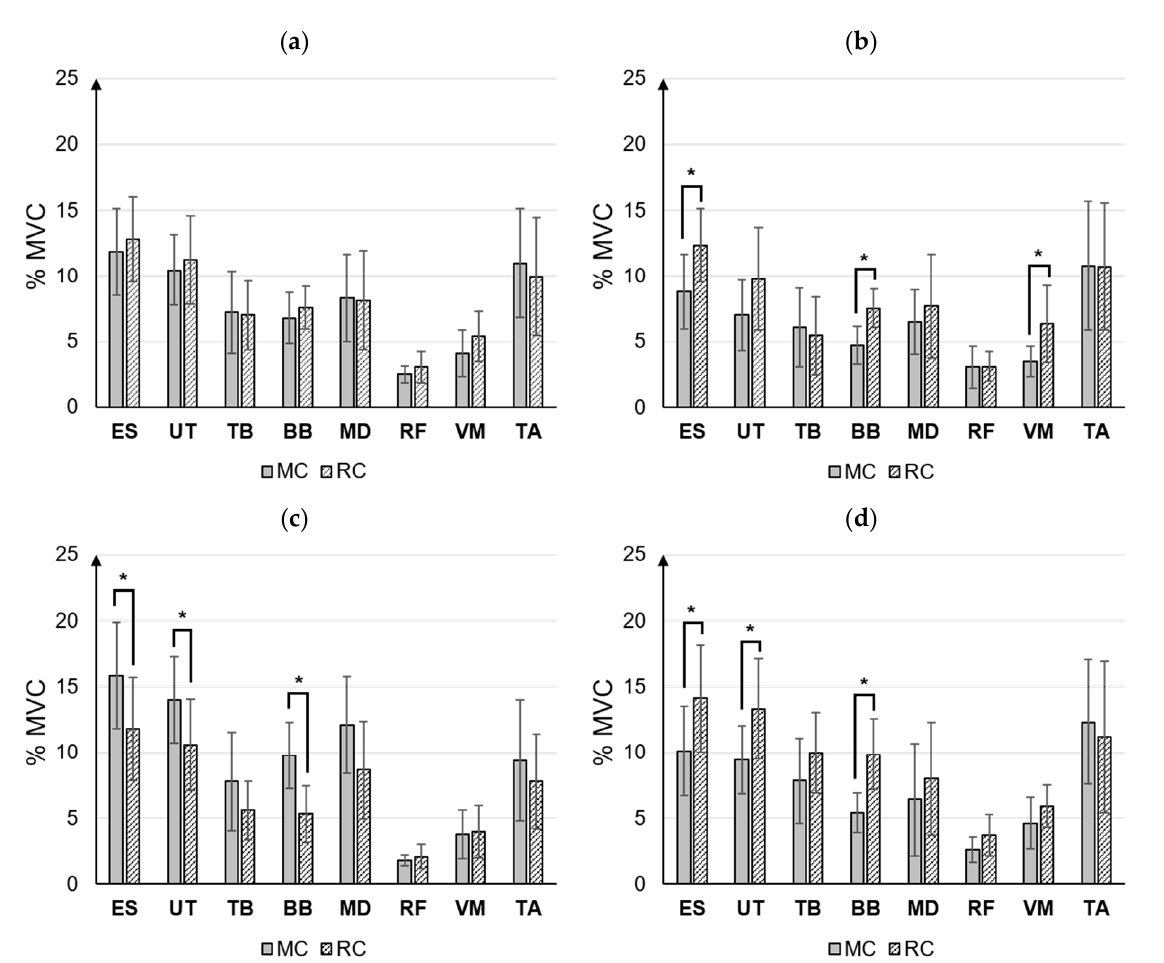
Figure 6. The comparison of muscular activity between MC and RC: ( a ) Total MC vs. Total RC, ( b ) Preparation MC vs. Preparation RC, ( c ) Front MC vs. Front RC, and ( d ) Post MC vs. Post RC. Note * p < 0.05.